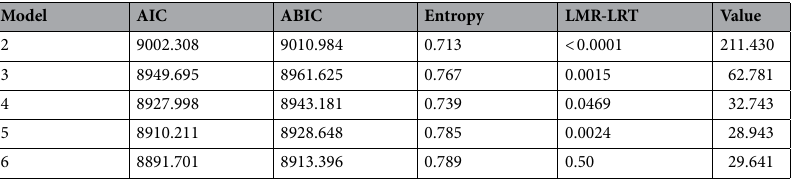
Table 2. Fit indicators for the 2 to 6 latent profile solutions. AIC Aikake Information Criterion, ABIC Sample- size adjusted Bayesian Information Criterion, LMR-LRT Lo-Mendell-Rubin Likelihood Ratio Test.